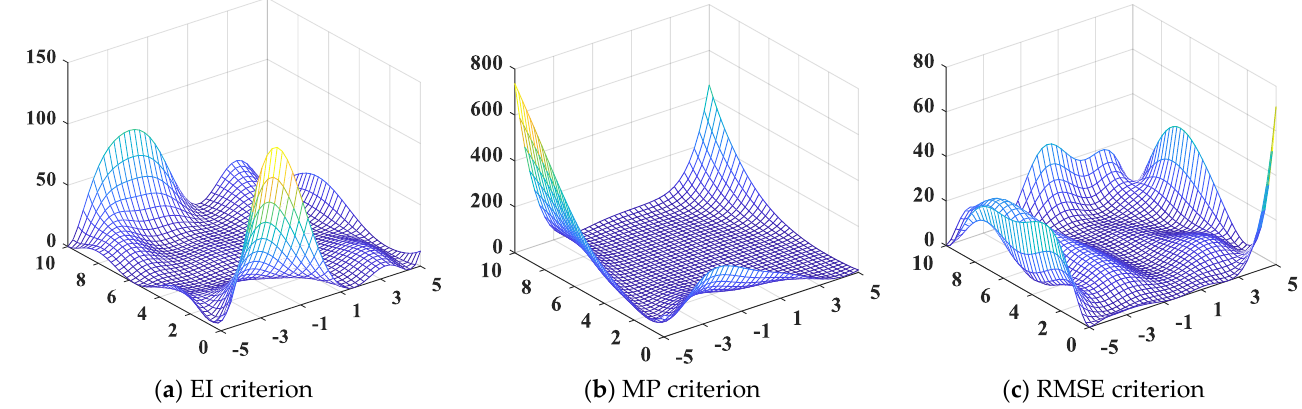
Figure 4. Test results on predicted MSE of other criteria on for Branin function.